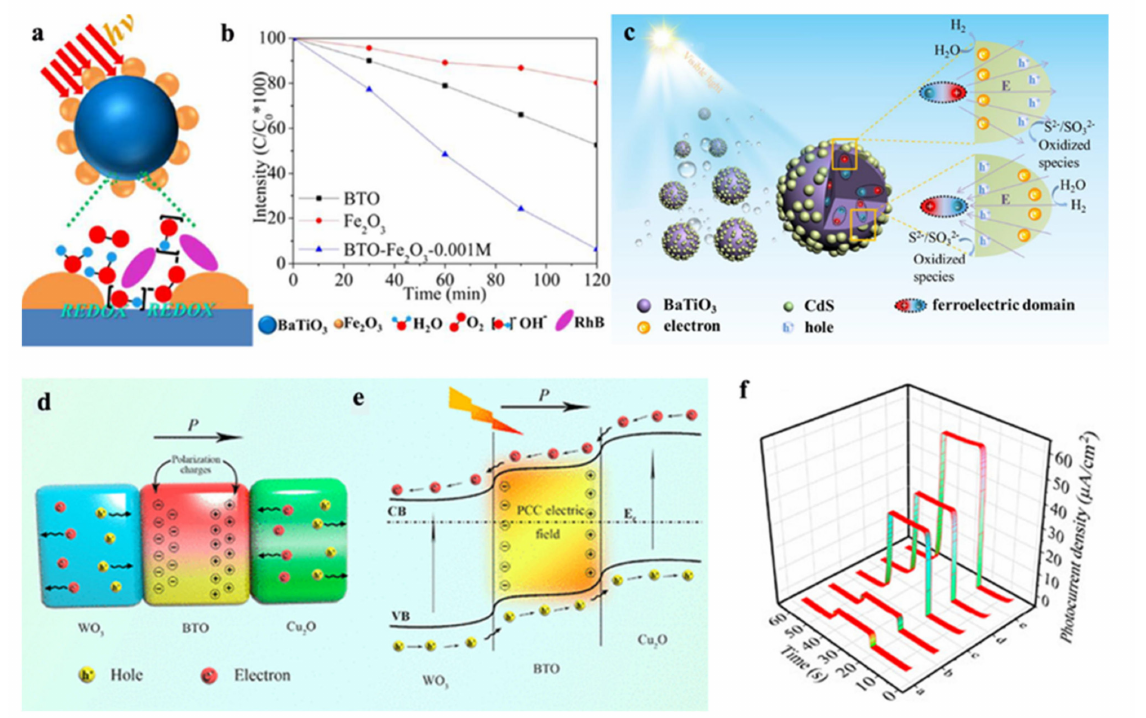
Figure 2. ( a ) Schematic island-like morphology of Fe 2 O 3 /BaTiO 3 and the triple points between the dye solution, Fe 2 O 3 and BaTiO 3 provide active sites for redox reactions; ( b ) photodecolorization profiles of RhB with different photocatalysts under simulated sunlight. Adapted with permission from ref. [39], copyright: 2017, American Chemical Society. ( c ) Schematic of photoinduced hole and electron migration in BaTiO 3 –CdS composites and photocatalytic hydrogen process under visible light; Adapted with permission from ref. [52], copyright: 2018, Elsevier. ( d ) Schematic diagram of the promoting effect of the PCC electric field on the separation of electron-hole pairs; ( e ) DSCC Strategy of the WO 3 Nanoflakes/BTO/Cu 2 O Photoelectrode; ( f ) photocurrent responses of WO 3 nanoflakes (curve a), WO 3 /BTO (curve b), WO 3 /Cu 2 O (curve c), WO 3 /Cu 2 O/BTO ( d ), and WO 3 /BTO/Cu 2 O after poling (curve e). Adapted with permission from ref. [47], copyright: 2020, American Chemical